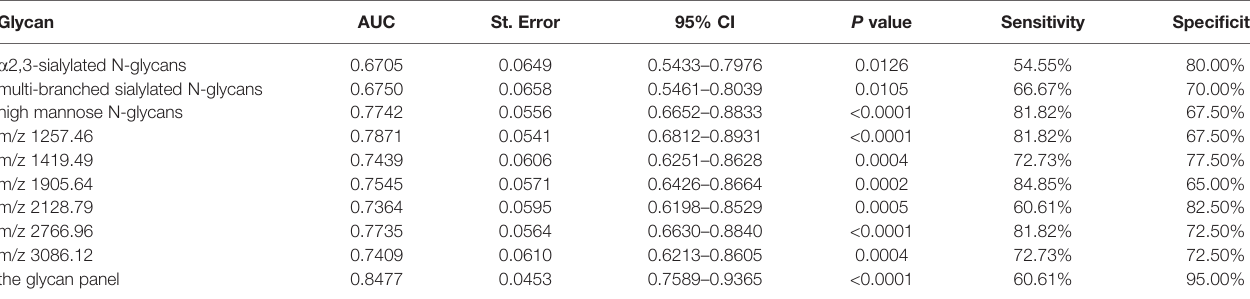
TABLE 2 | List of the three glyco-subclasses, six speci fi c N-glycans and the glycan panel that were evaluated to be speci fi c for neuroblastoma patients compared with non-malignant controls by Receiver Operating Characteristic (ROC) curve analysis. Glycan AUC St. Error